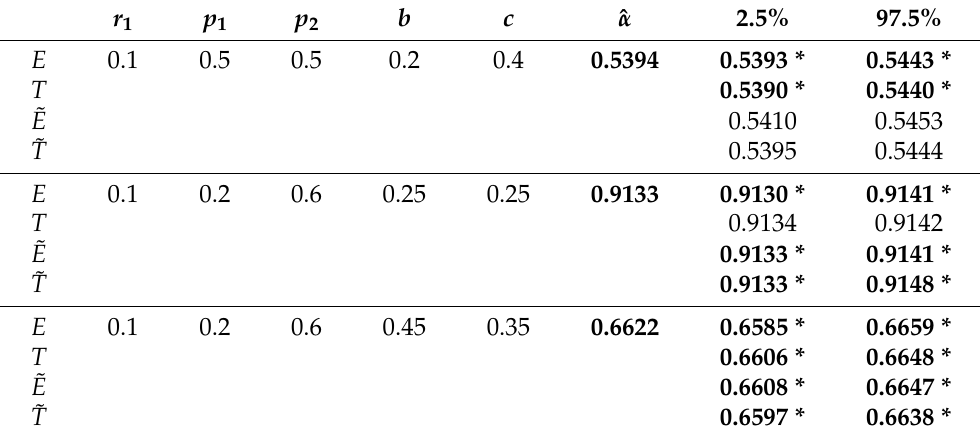
Table 1. The 95% confidence intervals for α .